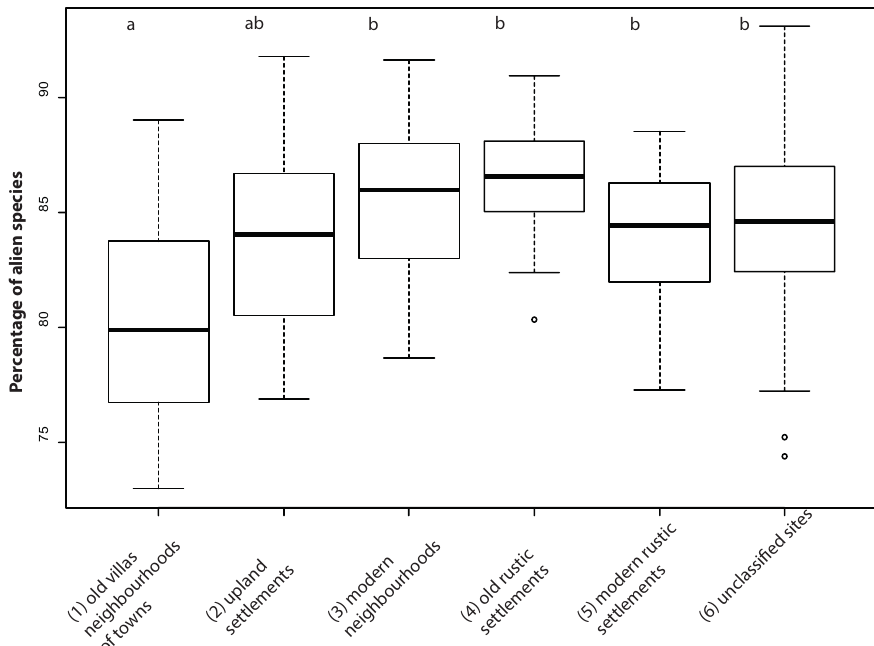
Figure 2. Differences in the percentages (i.e. median, 25 th and 75 th percentile and min/max values) of aliens amongst all ornamental taxa within clusters of the classified settlement types and within the unclas- sified cluster. Same letters above the boxes indicate insignificant differences between clusters (ANOVA F = 5.35, df (5, 168), p <